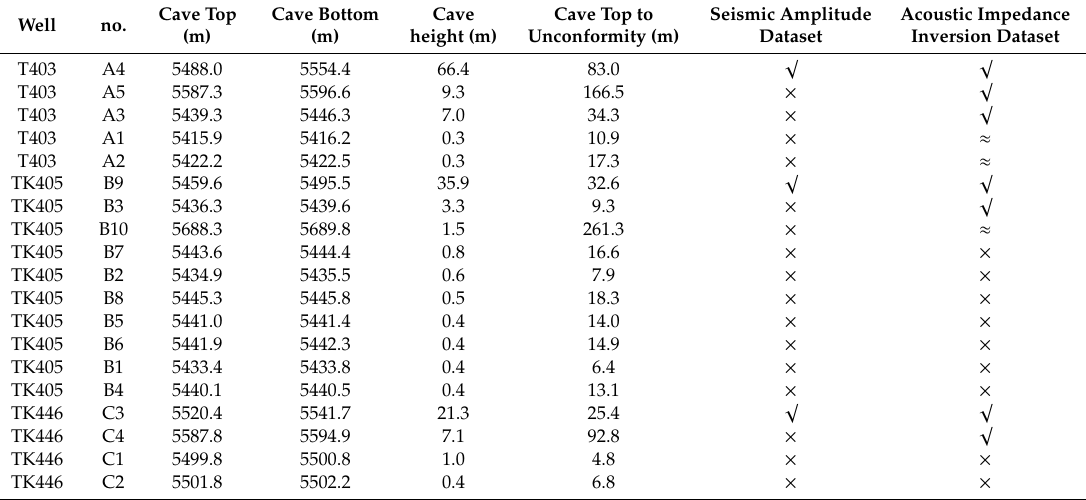
Table 2. The paleocaves drilled by wells T403, TK405, and TK446, and their recognized results by seismic